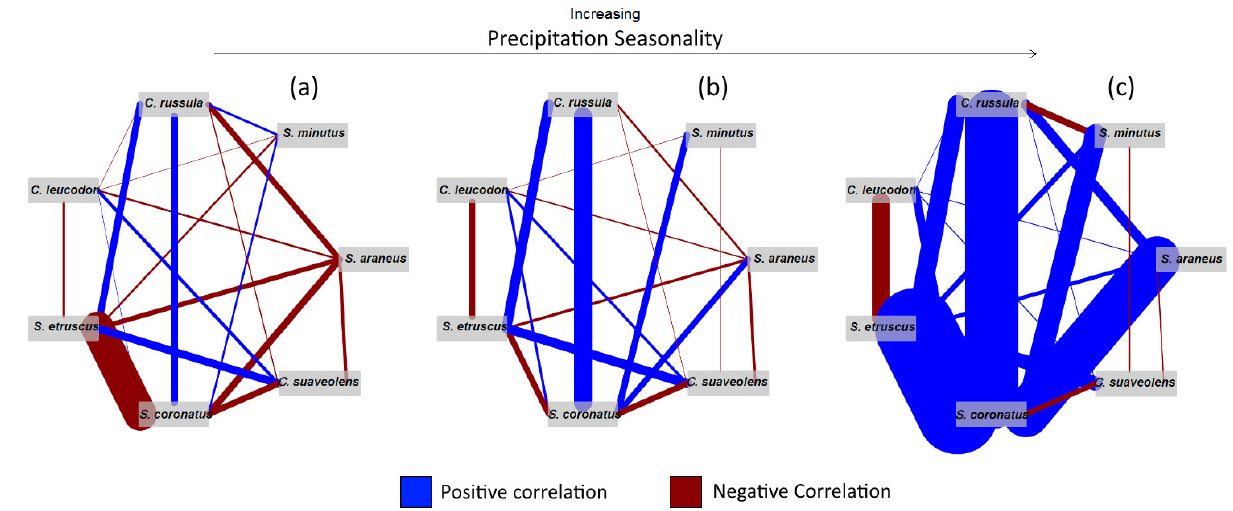
Figure 3. Results using Clark’s model. Correlation between pairs of species at the ( a ) 5th percentile, ( b ) 50th percentile, and ( c ) 95th percentile value of Precipitation Seasonality (Bio15). All other variables are at their average. The width of the lines represents correlation strength. Blue lines represent positive correlations, and red lines represent negative correlations.